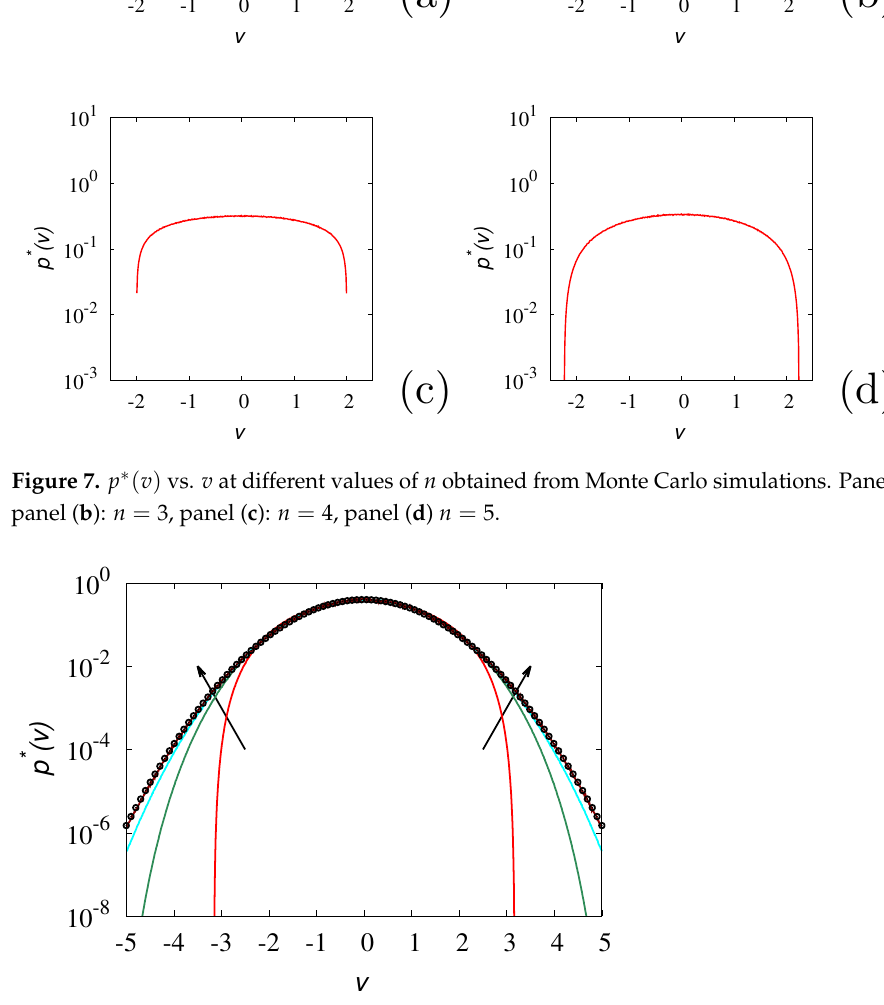
Figure 8. p ∗ ( v ) vs. v obtained from Monte Carlo simulations for large n . The arrows indicate increasing values of n = 10, 30, 100, 1000. Symbols ( • ) represent the normal distribution (with zero mean and unit